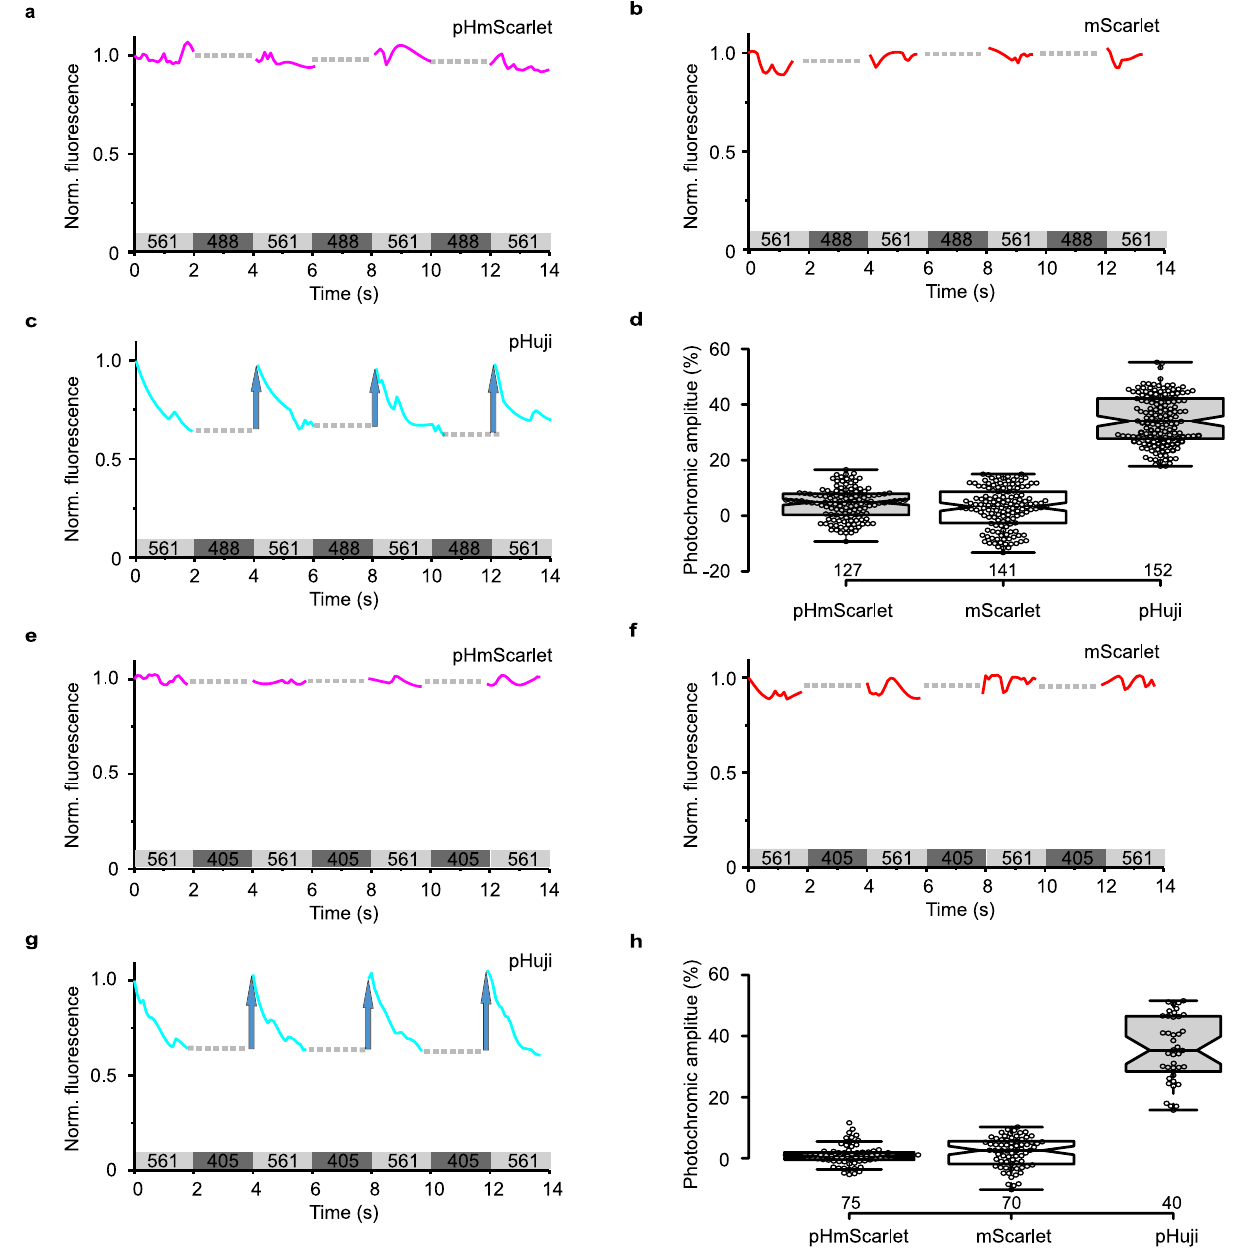
Fig. 2 Photochromic behavior of RFPs in U-2 OS cells. The cells were wide fi eld illuminated with alternating light of 561 nm and 488 nm ( a – c ) or 405 nm ( e – g ) lights for multiple illumination cycles. The photochromic amplitudes (blue arrows) of RFPs determined for each cycle are presented in ( d ) and ( h ). Boxplots were generated using BoxPlotR (http://boxplot.tyerslab.com/), which includes the median values, the individual data points, and the 95% con fi dence intervals (notches). d n = 14 cells for pHmScarlet, n = 14 cells for mScarlet, and n = 19 cells for pHuji examined. Independent experiments were repeated twice for each FPs. The median, upper whisker, and lower whisker are 5%, 17%, and – 9% for pHmScarlet, 3%, 15%, and – 13% for mScarlet, and 34%, 55%, and 18% for pHuji, respectively. h n = 5 cells for pHmScarlet, n = 7 cells for mScarlet, and n = 4 cells for pHuji. Independent experiments were repeated three times for each FPs. The median, upper whisker, and lower whisker are 1%, 5%, and – 4% for pHmScarlet, 3%, 10%, and – 10% for mScarlet, and 35%, 52%, and 16% for pHuji, respectively. a , e : pHmScarlet; b , f : mScarlet; c , g : pHuji. Source data is provided as a source data fi